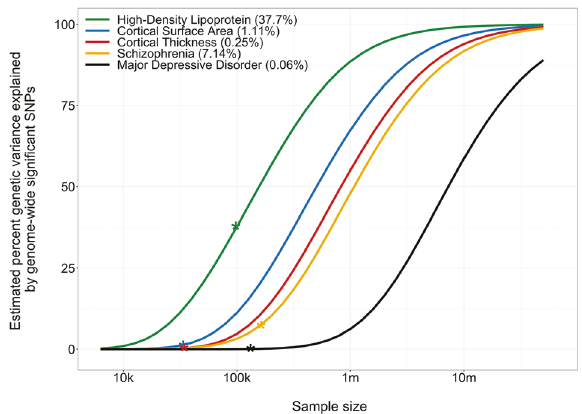
Fig. 2 Relation between sample size and proportion variance explained by genome-wide signi fi cant variants. This iss calculated through MiXeR [93] applied to summary statistics of recently conducted GWAS, with sample sizes indicated by stars [134 –